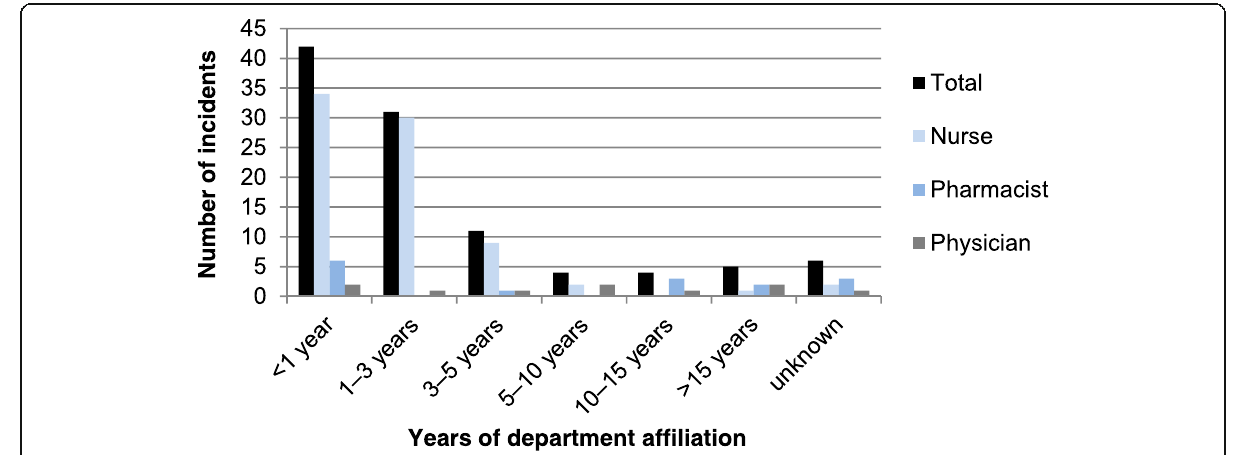
Fig. 3 Years of department affiliation of the persons involved in Kampo medicine-related